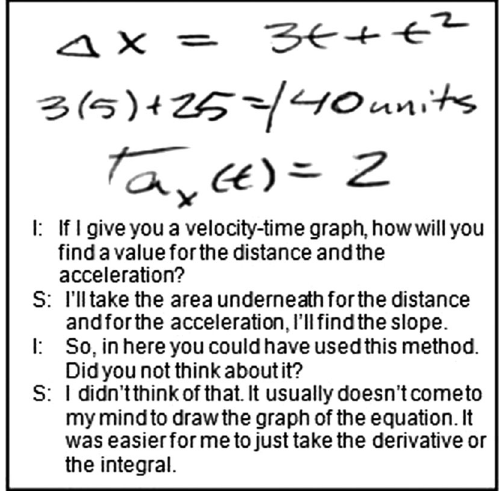
FIG. 12. Solve value from linguistic representation (question